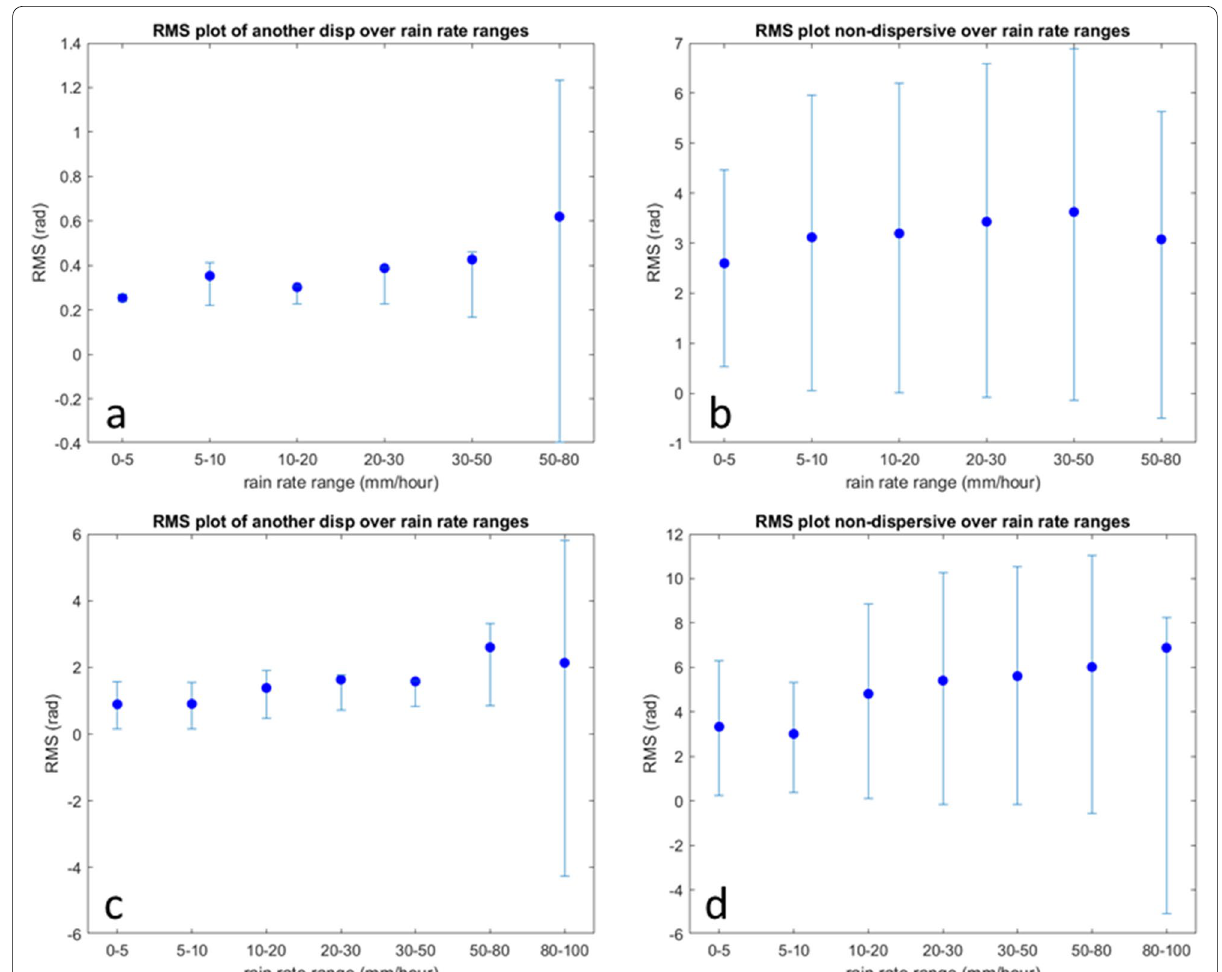
Fig. 10 RMS plot of �φ another_disp for ( a) Kyushu 20180731_20180828 and ( c) Shikoku 20180815_20181107. RMS plot of (cid:31) ∅ non-dispersive for ( b ) Kyushu 20180731_20180828 and ( d) Shikoku 20180815_20181107. The error bars represent 95% confidence